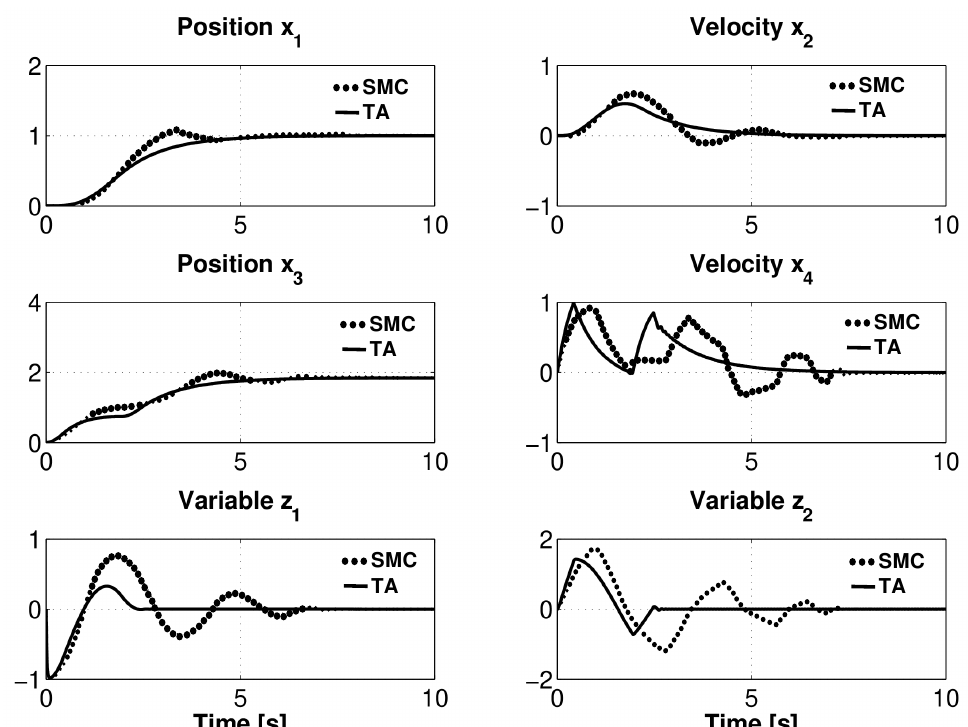
Figure 2. Closed-loop response comparison between the SMC of the bang–bang type (solid line) and the well-known twisting algorithm